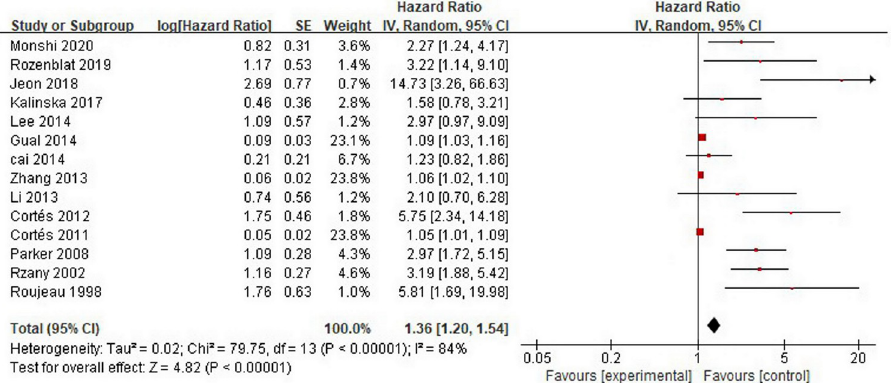
years among the studies. Meta-analysis showed that the overall pooled HR of advanced age was 1.36 (95%CI: 1.20–1.54, P < 0.001), and the results were statistically significant. Substantial heterogeneity was found among the studies ( P < 0.001, I 2 = 84%). Subgroup analysis for advanced age (Fig 3) showed that the pooled HR of a cut-off age of � 80 years was 1.38 (95%CI: 1.15–1.67, P < 0.001) and that of < 80 years was 2.18 (95%CI: 1.36– 1.54, P = 0.001); both results were statistically significant. The heterogeneity test of the two subgroups showed the following: age � 80 years ( P < 0.001, I 2 = 88%) and age < 80 years ( P < 0.001, I 2 = 82%). The sensitivity analysis was performed on the studies. There was no change in the effect and similar heterogeneity after the exclusion of each study one by one. The results were still statistically significant (HR = 1.23, 95%CI: 1.10–1.38, P < 0.001), and substantial heterogeneity was found ( P < 0.001, I 2 = 80%) after excluding the studies [22,23] that provided RR. The result showed that HR = 1.44(95%CI: 1.21–1.72, P < 0.001), and the heterogeneity was substantial ( P < 0.001, I 2 = 84%) after excluding the studies in which the endpoint indicator was not one- year mortality [12,16,18–20,23].